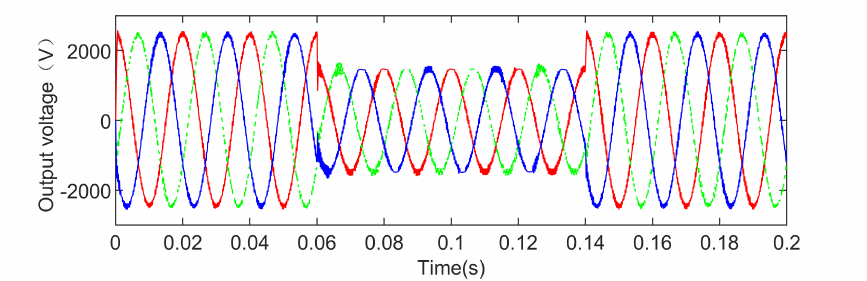
Figure 3. Output voltage ( u oa , u ob , u oc ) waveforms under desired value change.